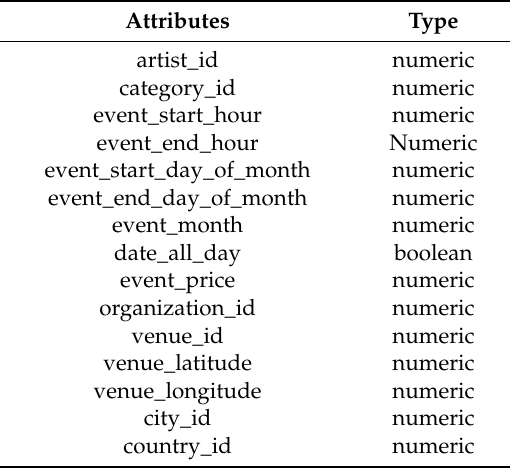
Table 3. Classes, properties and facets of LODSE